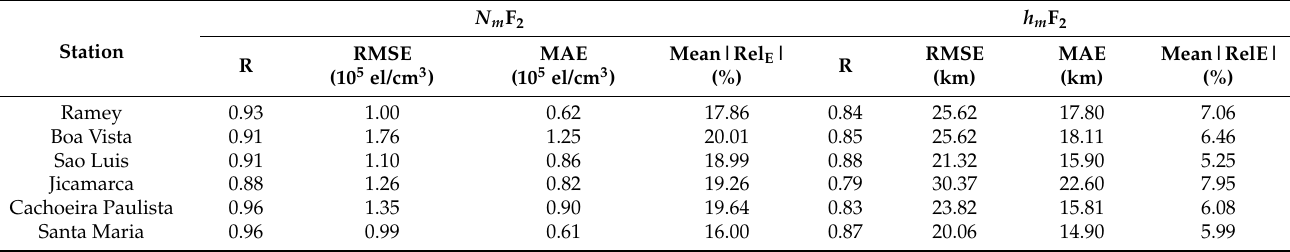
Table 2. Statistics of the differences in N m F 2 and h m F 2 obtained from the COSMIC-2 and ionosonde (as the reference) at the six ionosondes under quiet geomagnetic conditions.